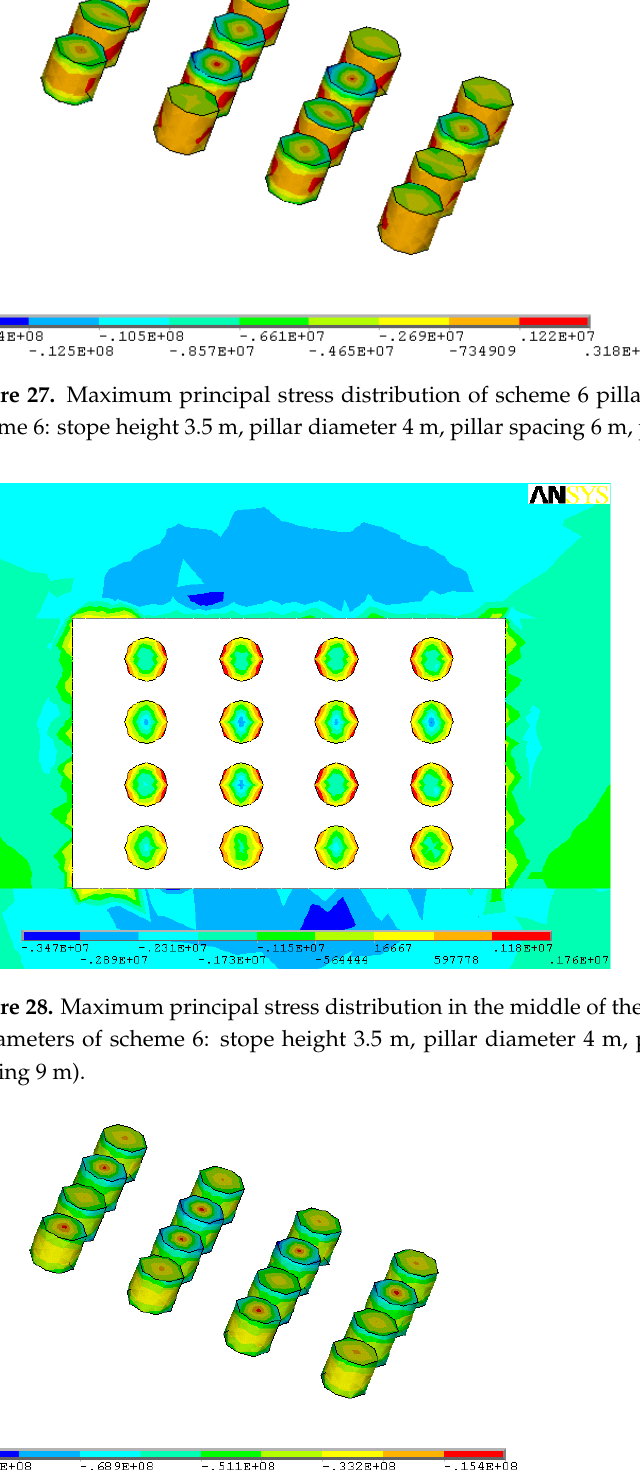
Figure 29. Minimum principal stress distribution of scheme 6 pillars at 1480 mL (parameters of scheme 6: stope height 3.5 m, pillar diameter 4 m, pillar spacing 6 m, pillar row spacing 9 m).